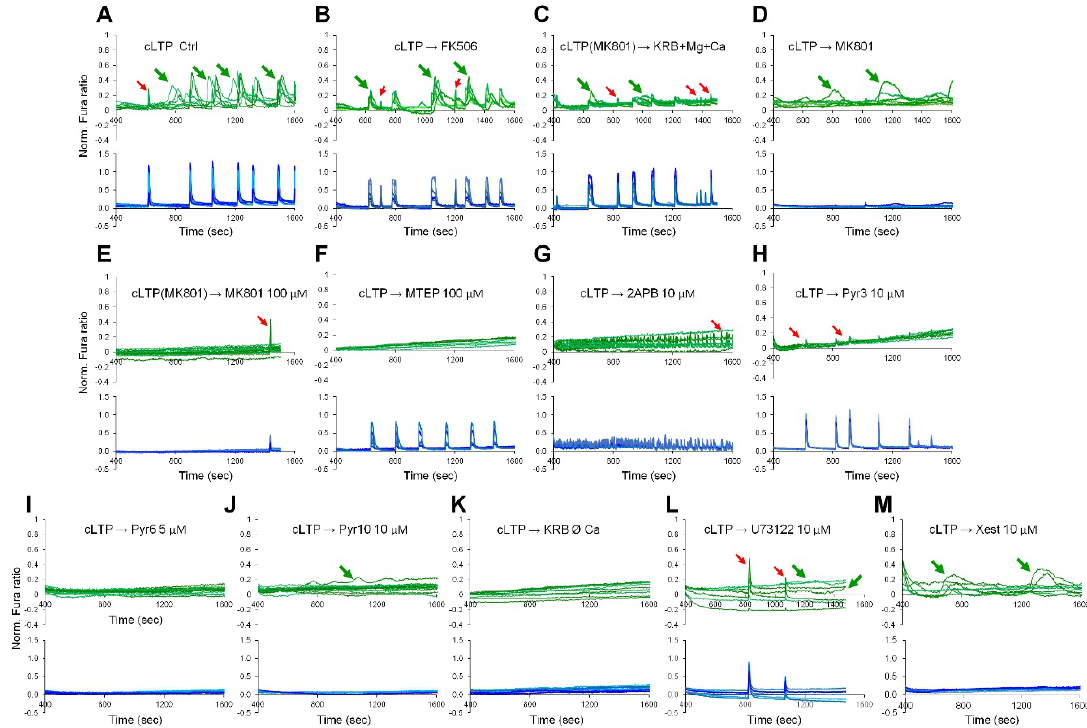
Figure 5. Pharmacological characterization of cLTP-induced astroglial Ca 2+ signals. Fura-2 loaded hippocampal mixed neuron-astroglial cultures were stimulated with cLTP protocol and either not treated ( A ) or treated as indicated (unless otherwise stated cells were treated during cLTP development phase): FK506 (200 nM) ( B ); MK801 (100 μM, only in the phase of cLTP induction) ( C ); MK801 (100 μM, only in the phase of cLTP development) ( D ); MK801 (100 μM, during both phases, cLTP induction and development) ( E ); MTEP (100 μM) ( F ); 2APB (10 μM) ( G ); Pyr3 (10 μM) ( H ); Pyr6 (5 μM) ( I ); Pyr10 (10 μM) ( J ); Ø Ca 2+ ( K ); U73122 (10 μM) ( L ); Xestospongin C (10 μM) ( M ). Ca 2+ signals were analyzed separately in astrocytes (green traces) and in neurons (blue traces). Only parts of traces related to cLTP development phase are shown. cLTP induced Ca 2+ elevation in astrocytes are indicated by green arrows. Artifacts related to neuronal Ca 2+ spikes are indicated with red arrows. For corresponding full-length traces, see Figure S2.